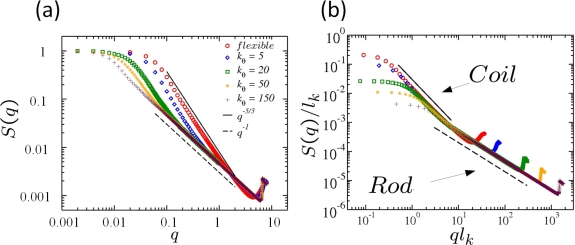
(a) S(q) of single linear chains with N = 700 and varying stiffness kθ. The scaling regimes (fully flexible and stiff rod) are indicated by a straight and dashed line, respectively. (b) Scaling plot of S(q)/lK versus q · lK using the statistical segment length lK adapted from [208].